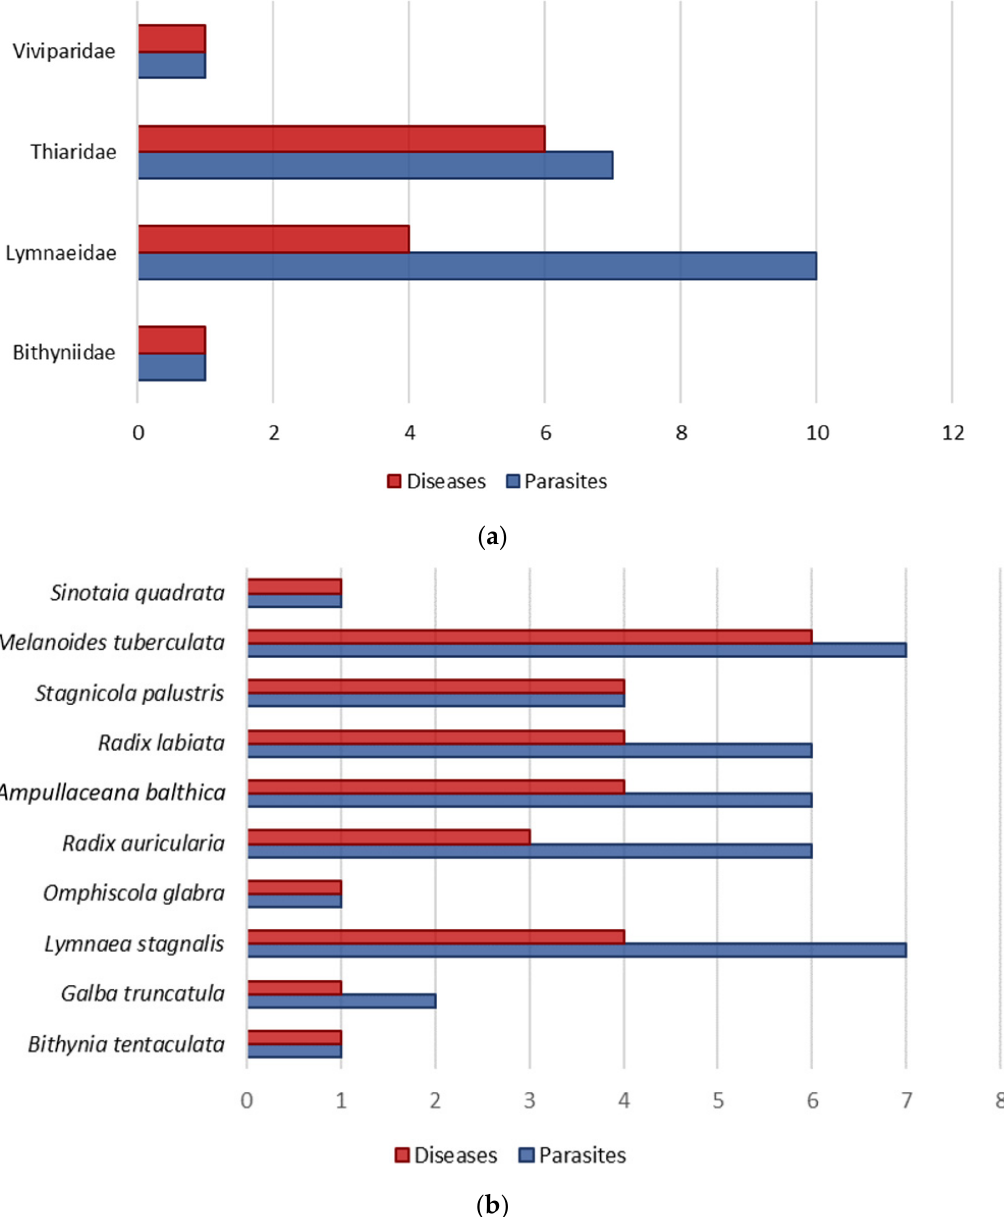
Figure 8. Diversity of parasites (blue) and diseases (red) transmitted by ( a ) Freshwater mollusc families and ( b ) Freshwater mollusc species.